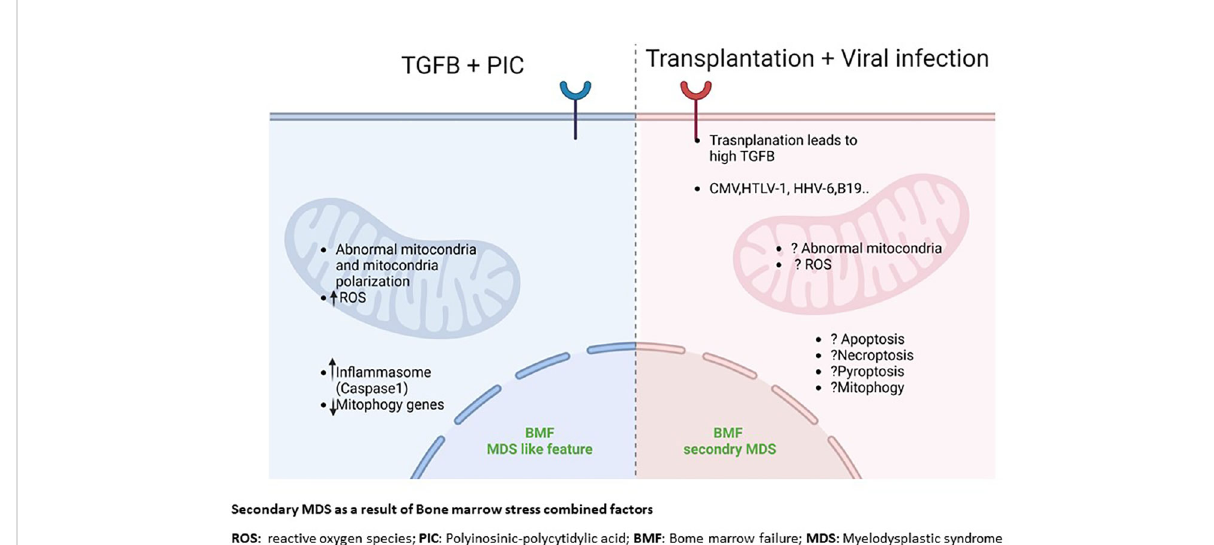
FIGURE 2 Secondary MDS as a result of Bone marrow stress combined factors. ROS, reactive oxygen species; PIC, Polyinosinic-polycytidylic acid; BMF, Bome marrow failure; MDS, Myelodysplactic